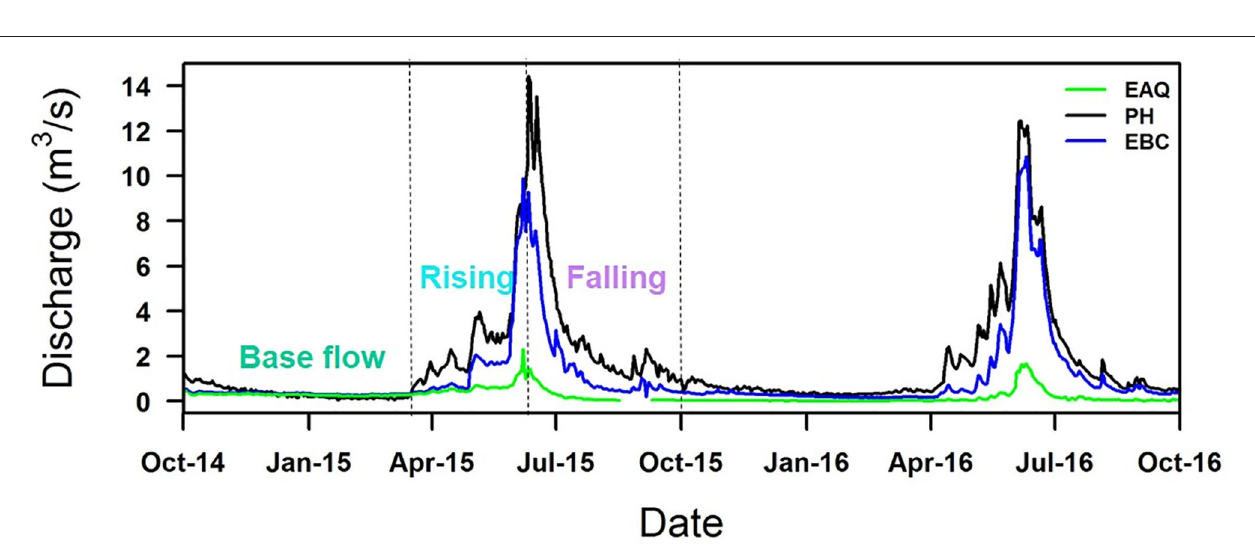
FIGURE 3 | Discharge rates measured at East Above Quigley (EAQ), Pump House (PH), and East Below Copper (EBC) stations for two consecutive water years. Discharge represents distinct seasonal trends, being higher in snowmelt-dominated spring months than in winter. Note that the C-Q relationships were analyzed on the basis of the discharge graph separation into base flow, rising and falling limb components as shown here.